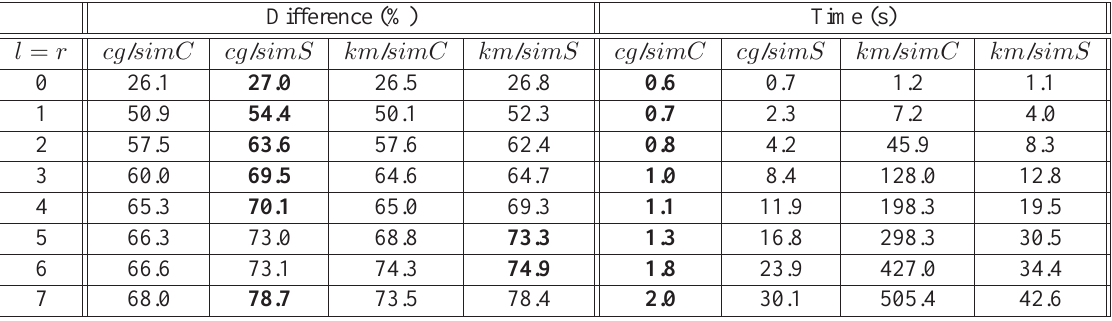
Table 1: This table was taken from [10] and summarizes the average information content im- provements and the mean running times of MoRAine 1.0 for different l - and r -values and the four search method/similarity function combinations over all TFBSs of 85 transcriptional regulators of E.coli.